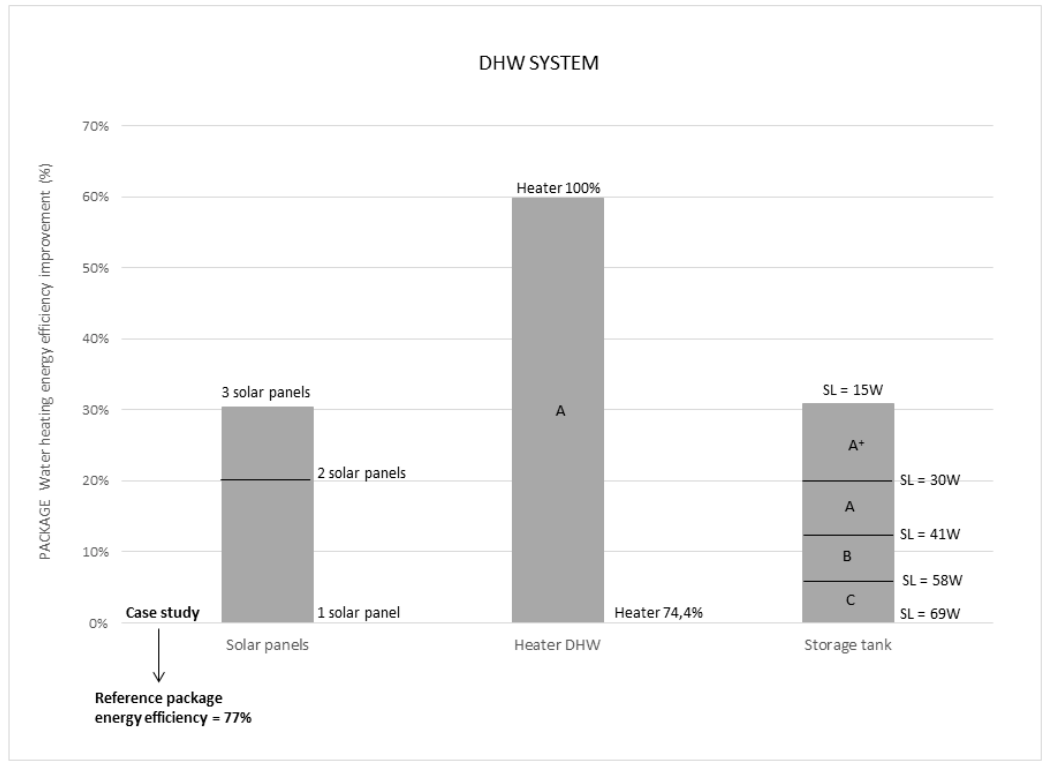
Figure 7. Contribution of individual products to the water heating energy efficiency improvement of the package.